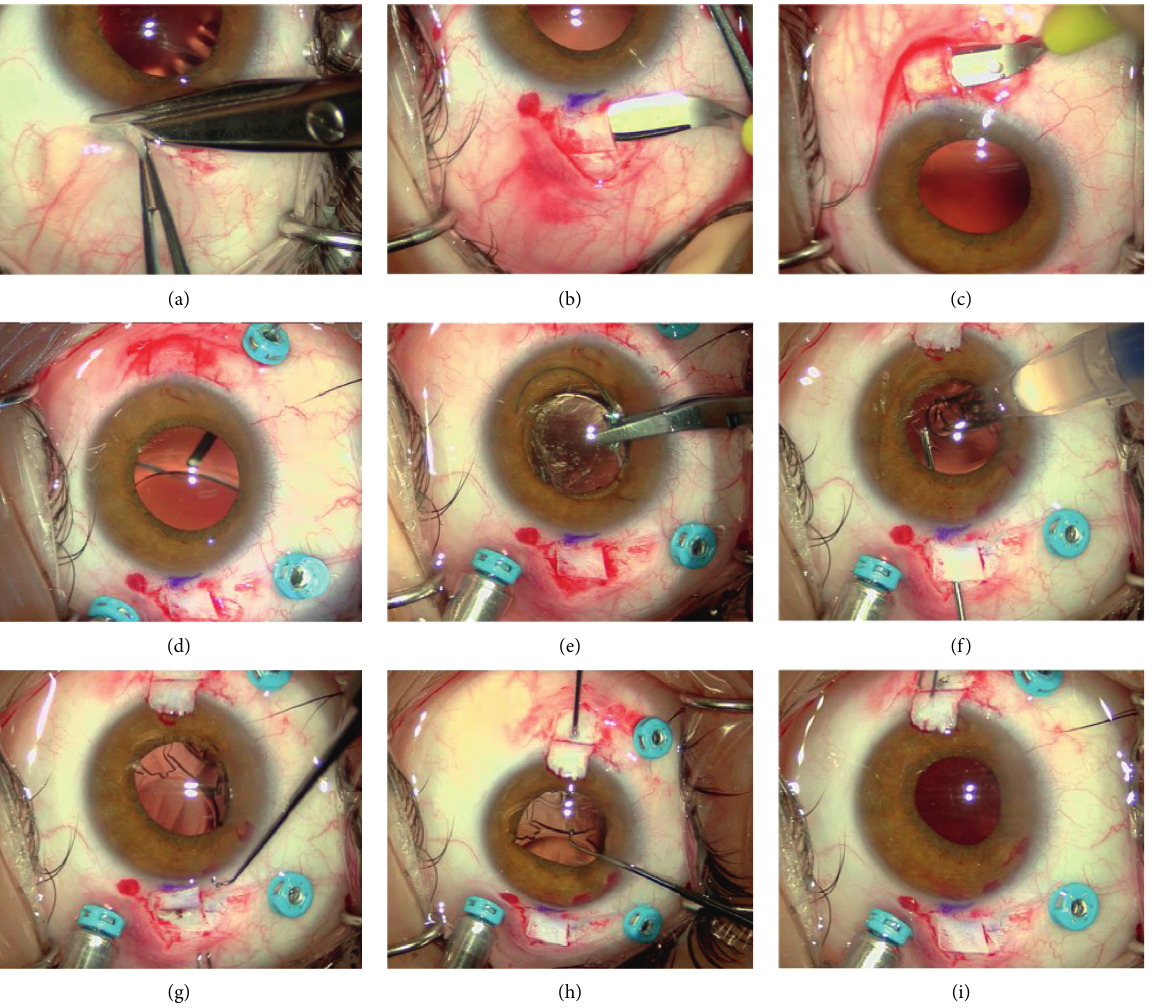
Figure 2: FILSSF IOL implant procedure: conjunctival peritomy (a), scleral flaps creation (b, c), vitrectomy (d), dilocated IOL removal (e), haptics grasping (f, h), and externalization (g,